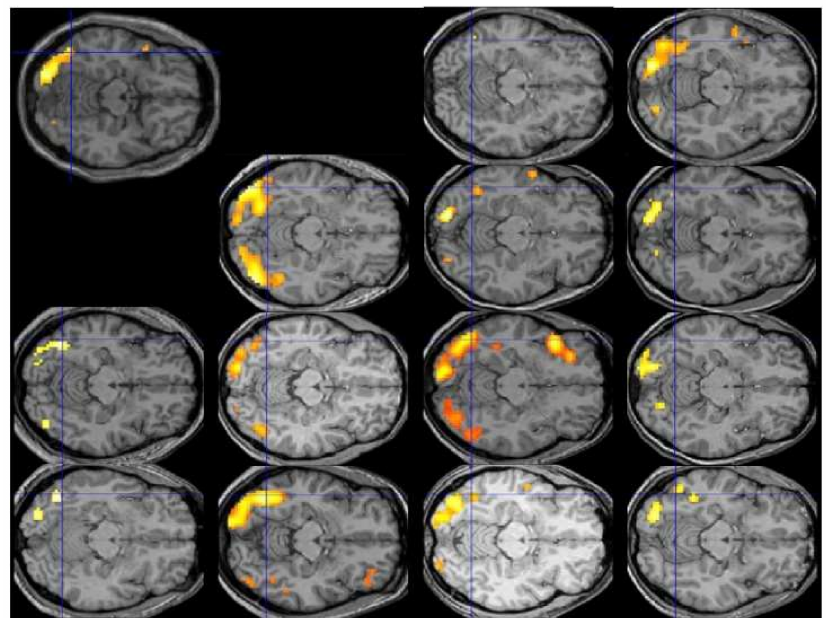
Figure 1. Results of individual-subject analysis (1st level) and group analysis (2nd level; top left image) for reading vs. fixation in SPM5 using data from the first 13 participants volunteering for the study of Protopapas et al. [63]. Significant activation ( p < 0.001, uncorrected) for the contrast [0.5 × words + 0.5 × pseudowords − fixation] is shown on horizontal slice z = − 14 of individual participants’ own normalized and coregistered structural (T1) images, and on SPM8 (Wellcome Trust Centre for Neuroimaging, London, UK; http://www.fil.ion.ucl.ac.uk/spm/software/spm8/) default for the group result. Blue crosshair at x = − 45 y = − 64 in all images. See [63] for details on